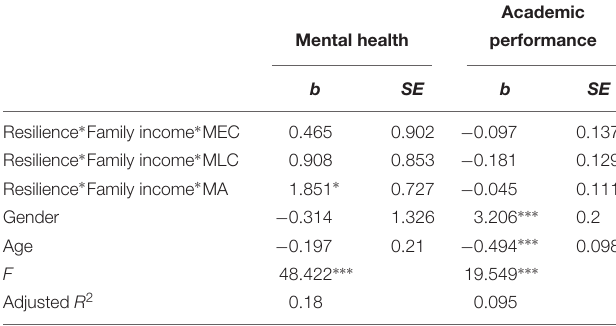
TABLE 2 | The results of the linear regression models tested for mental health and academic performance.